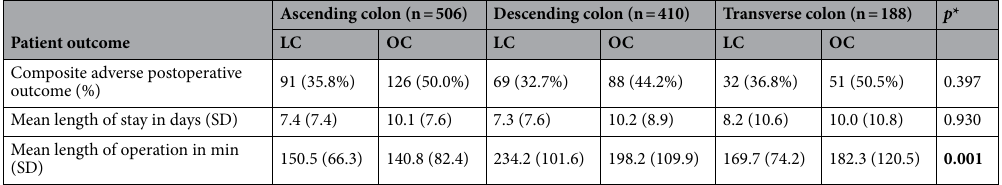
Table 4. Effect of laparoscopic versus open colectomy by type of tumor location, NSQIP 2013–2015. * p < 0.05 based on propensity score-matched patients comparing tumor location. LC: laparoscopic colectomy; OC: Open colectomy; SD: standard deviation. Composite outcome includes readmission, reoperation, wound infection, blood transfusion, prolonged ileus, sepsis, myocardial infarction, deep vein thrombosis, pulmonary embolism, and mortality.